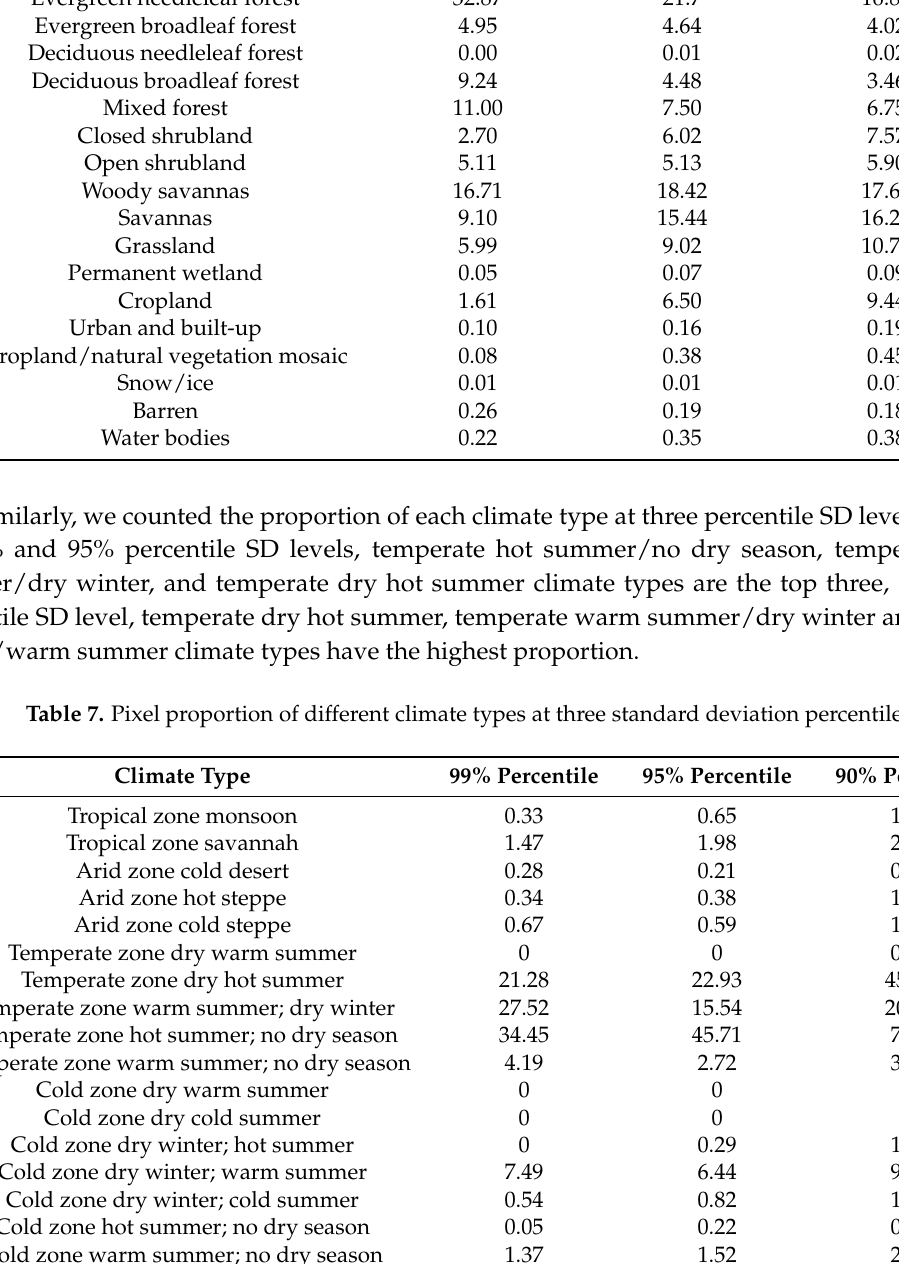
Table 6. Pixel proportion of different biome types at three standard deviation percentiles. Biome Type